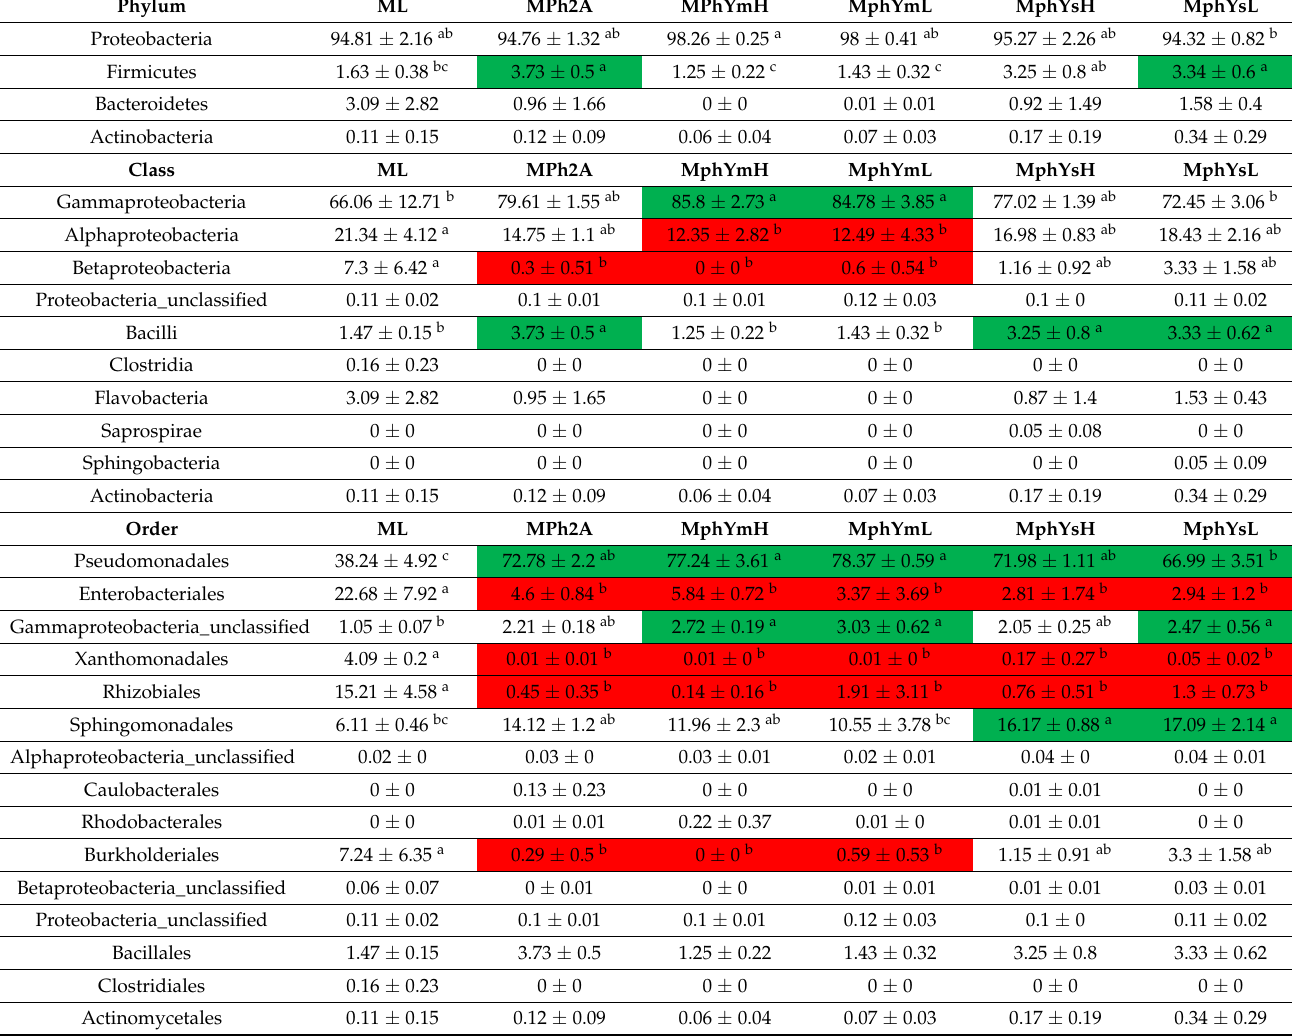
Table 2. Relative abundance of maize endophytes as dominant phyla, classes, and orders in all tested culture-independent and culture-dependent samples (average ± standard error of the